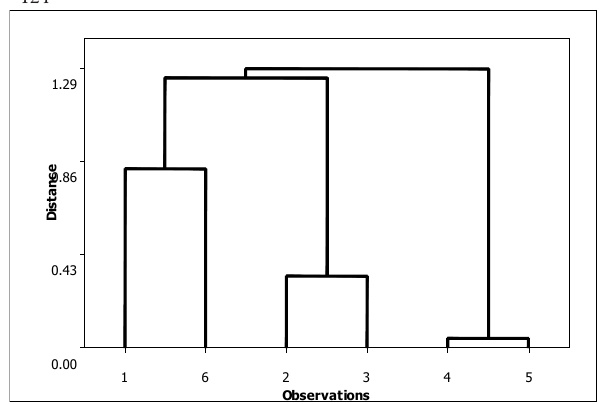
Fig. 1. Dendrogram of analyzed wheat lines developed in Ko-